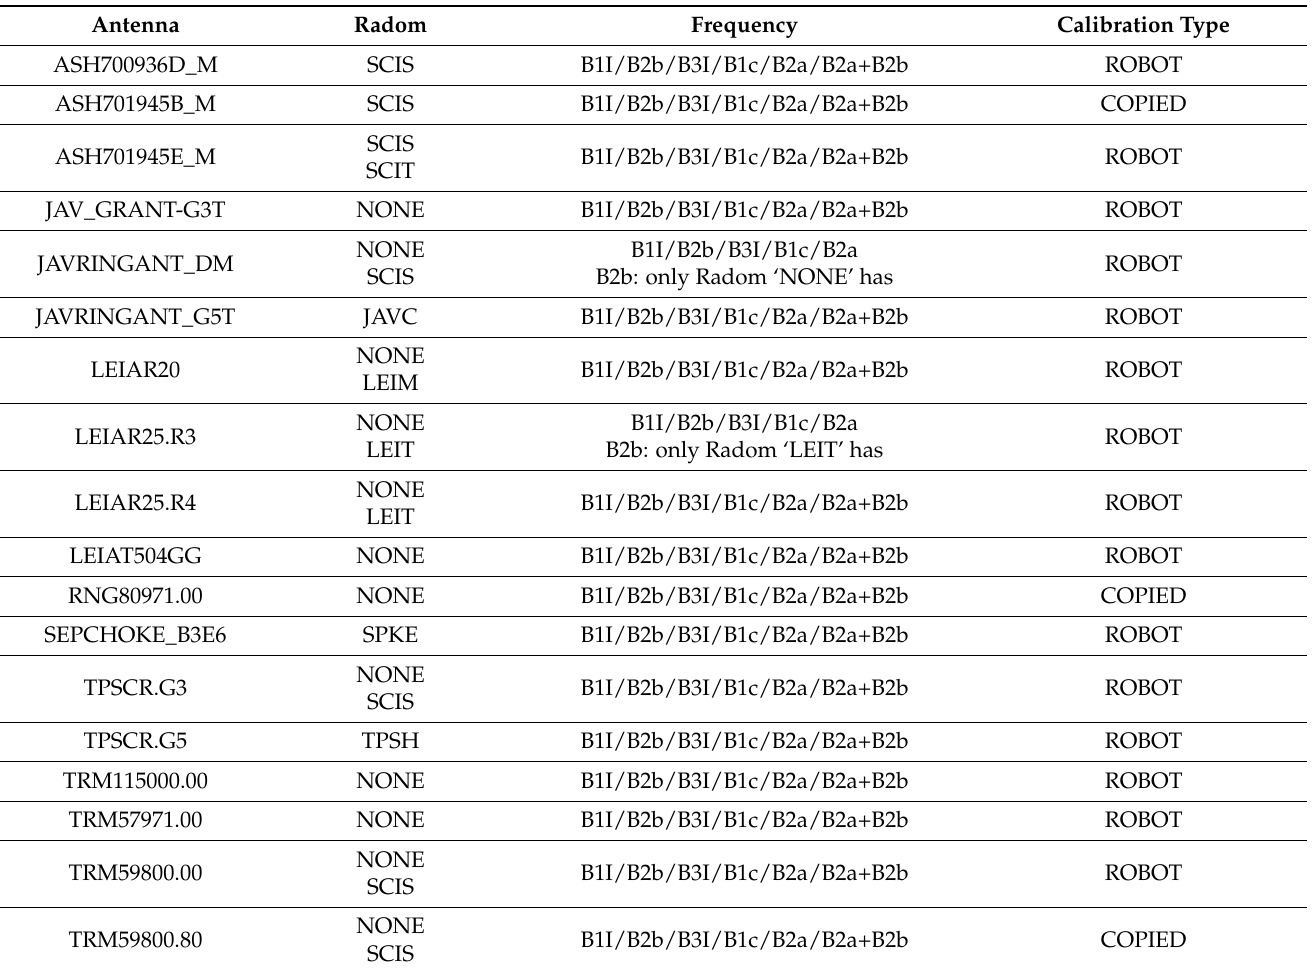
Table 2. Antenna/radome combinations with phase center corrections (PCC) available for BDS B1I and B3I signals in